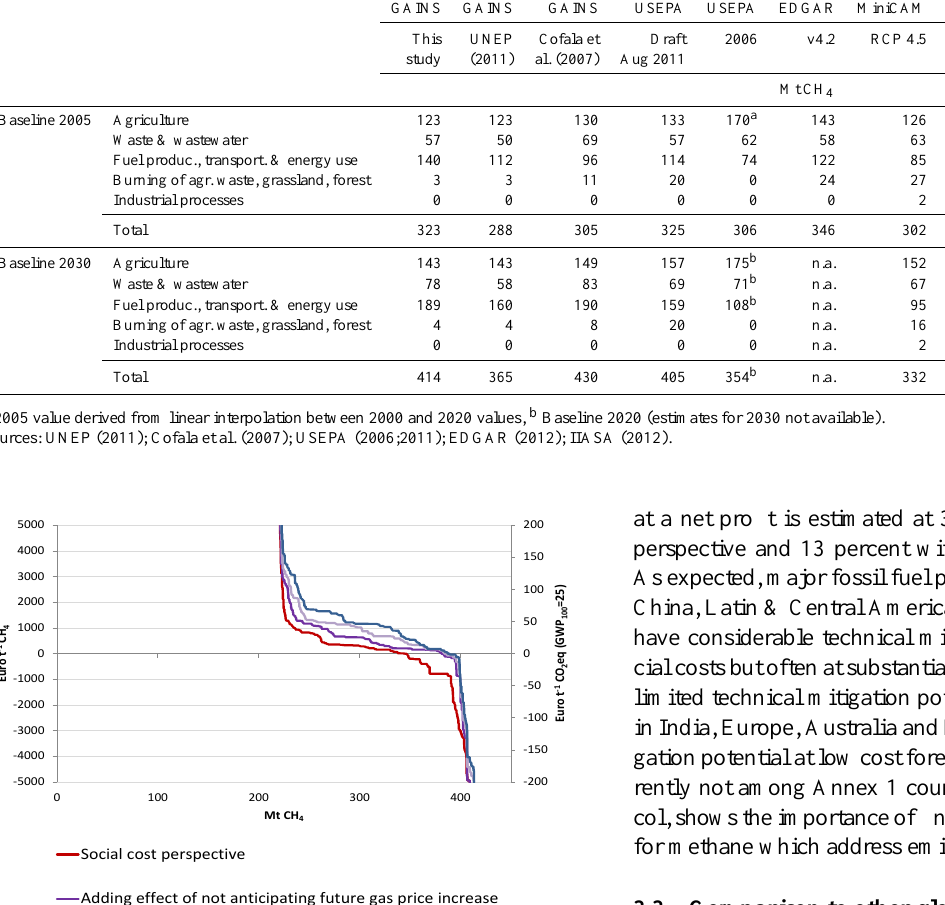
Table 9. Comparison of GAINS model results for baseline global anthropogenic CH 4 emissions with the results of other models. Year